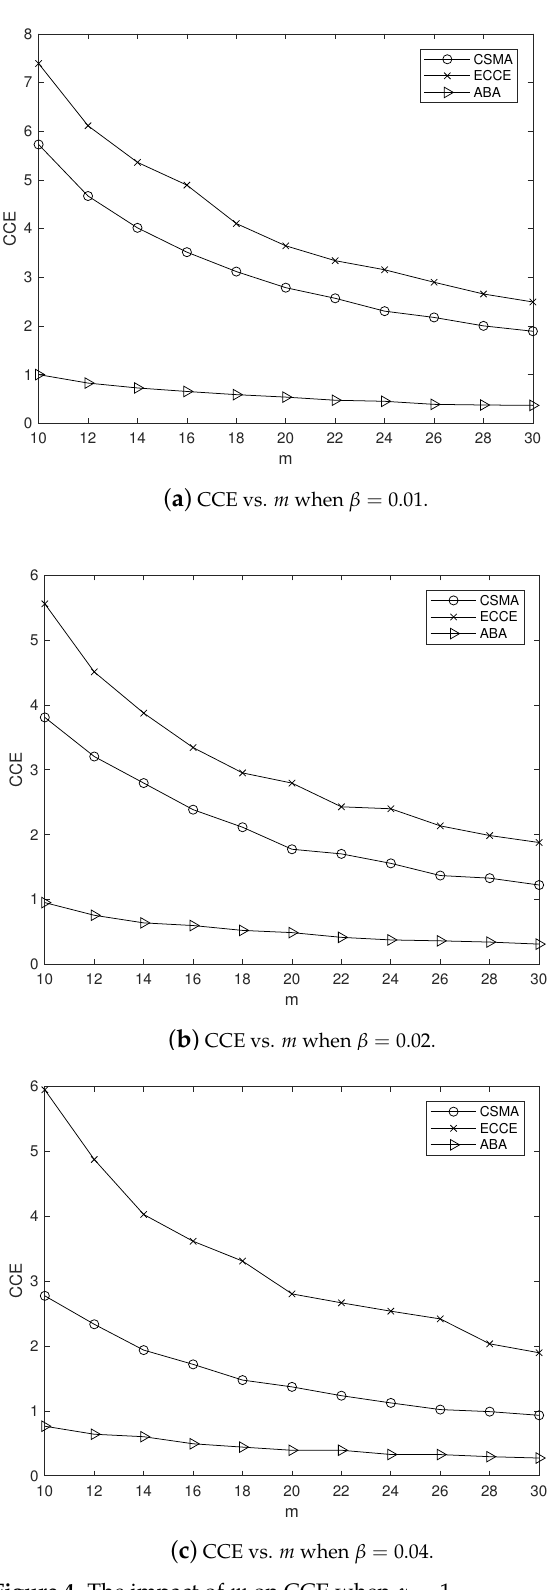
Figure 4. The impact of m on CCE when α =